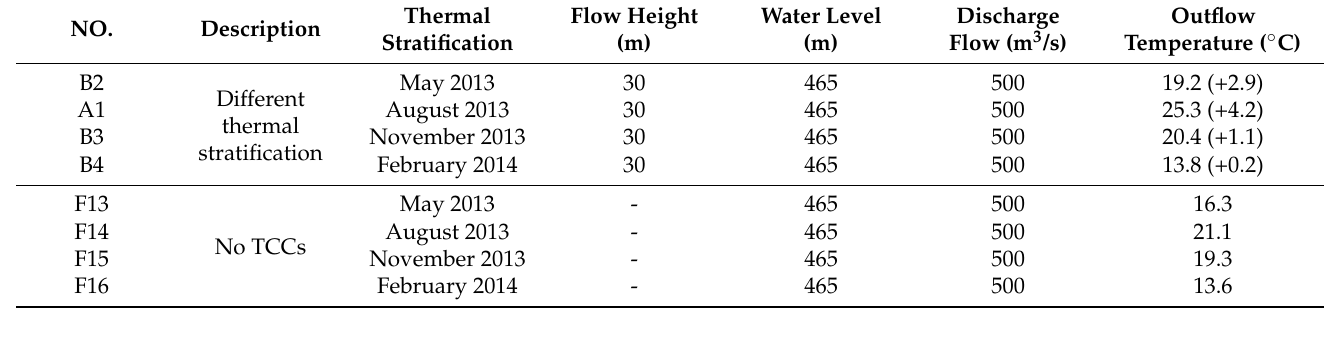
Table 5. Different thermal stratification test scenarios and results.